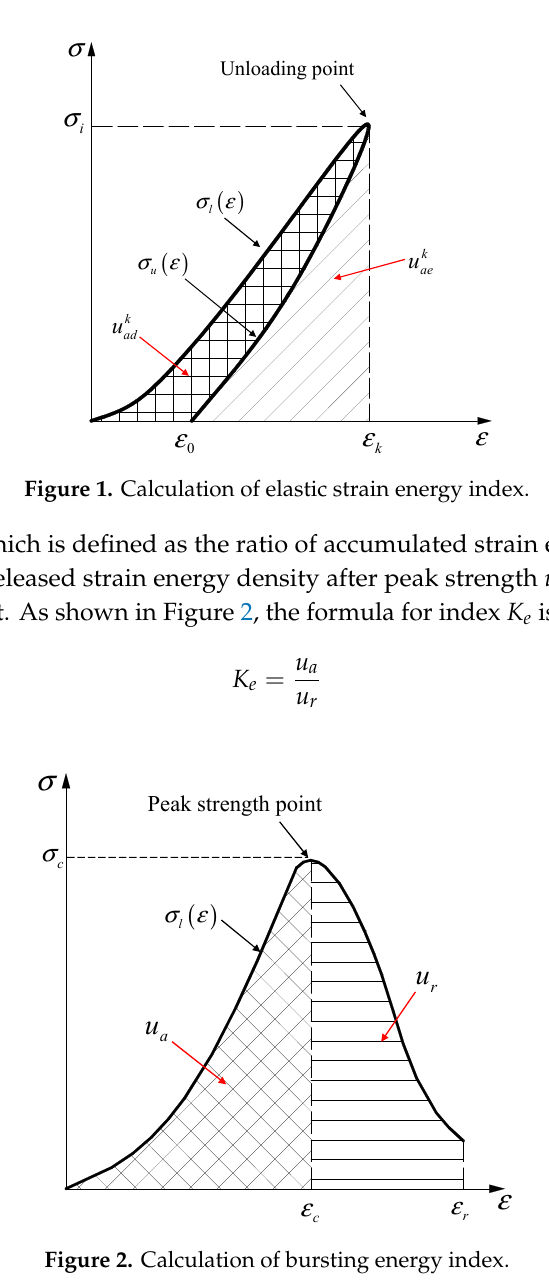
Figure 1. Calculation of elastic strain energy index.